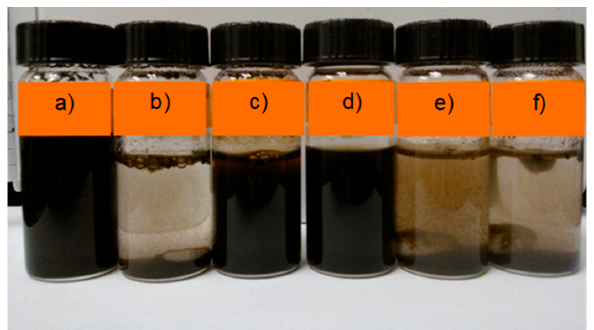
Figure 2. The visual appearance of 0.02 g GO and GO treated with 0.01 g different modifiers in the deionized water, 10 minutes after agitation was stopped, ( a ) neat GO, ( b ) GO with VBTAC, ( c ) GO with AMPS, ( d ) GO with SDBS, ( e ) GO with OTAB, ( f ) GO with MTAB.